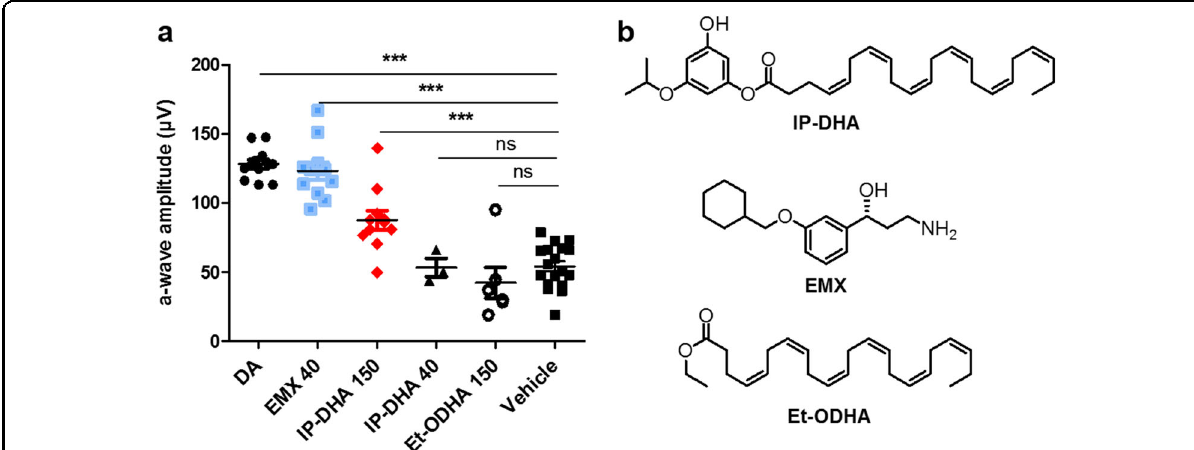
Fig. 7 Comparative protective effects of IP-DHA, DHA ethyl ester, and EMX on light-induced retinal degeneration. a Dark-adapted (DA) 8 – 9- week-old Abca 4 − / − mice were treated by oral gavage with emixustat (EMX, 40 mg/kg, 24 h), IP-DHA (40 and 150 mg/kg, 6 h), or DHA ethyl ester (Et-ODHA 150 mg/kg, 6 h), pupils were dilated, and mice were exposed to light for 2 h. The mice were returned to the dark for 5 days before full- fi eld ERG recordings. The a-wave amplitudes were recorded at 2-log cd.s/m 2 light intensity for each treatment and statistically compared to the amplitude of mice treated with the vehicle (soybean oil). Data are expressed as the mean ± SEM. Three asterisk, one-way ANOVA with Bonferroni ’ s multicomparison test: p < 0.001, DA ( n = 12), 40 mg/kg EMX ( n = 11), 150 mg/kg IP-DHA ( n = 11), 40 mg/kg IP-DHA ( n = 3), 150 mg/kg